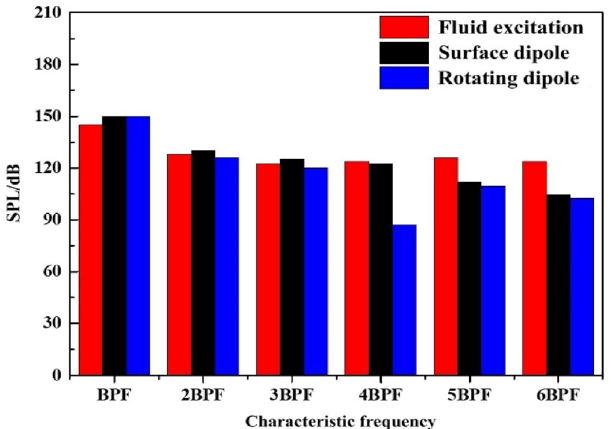
Figure 9. Sound pressure level at each characteristic frequency of different excitations.